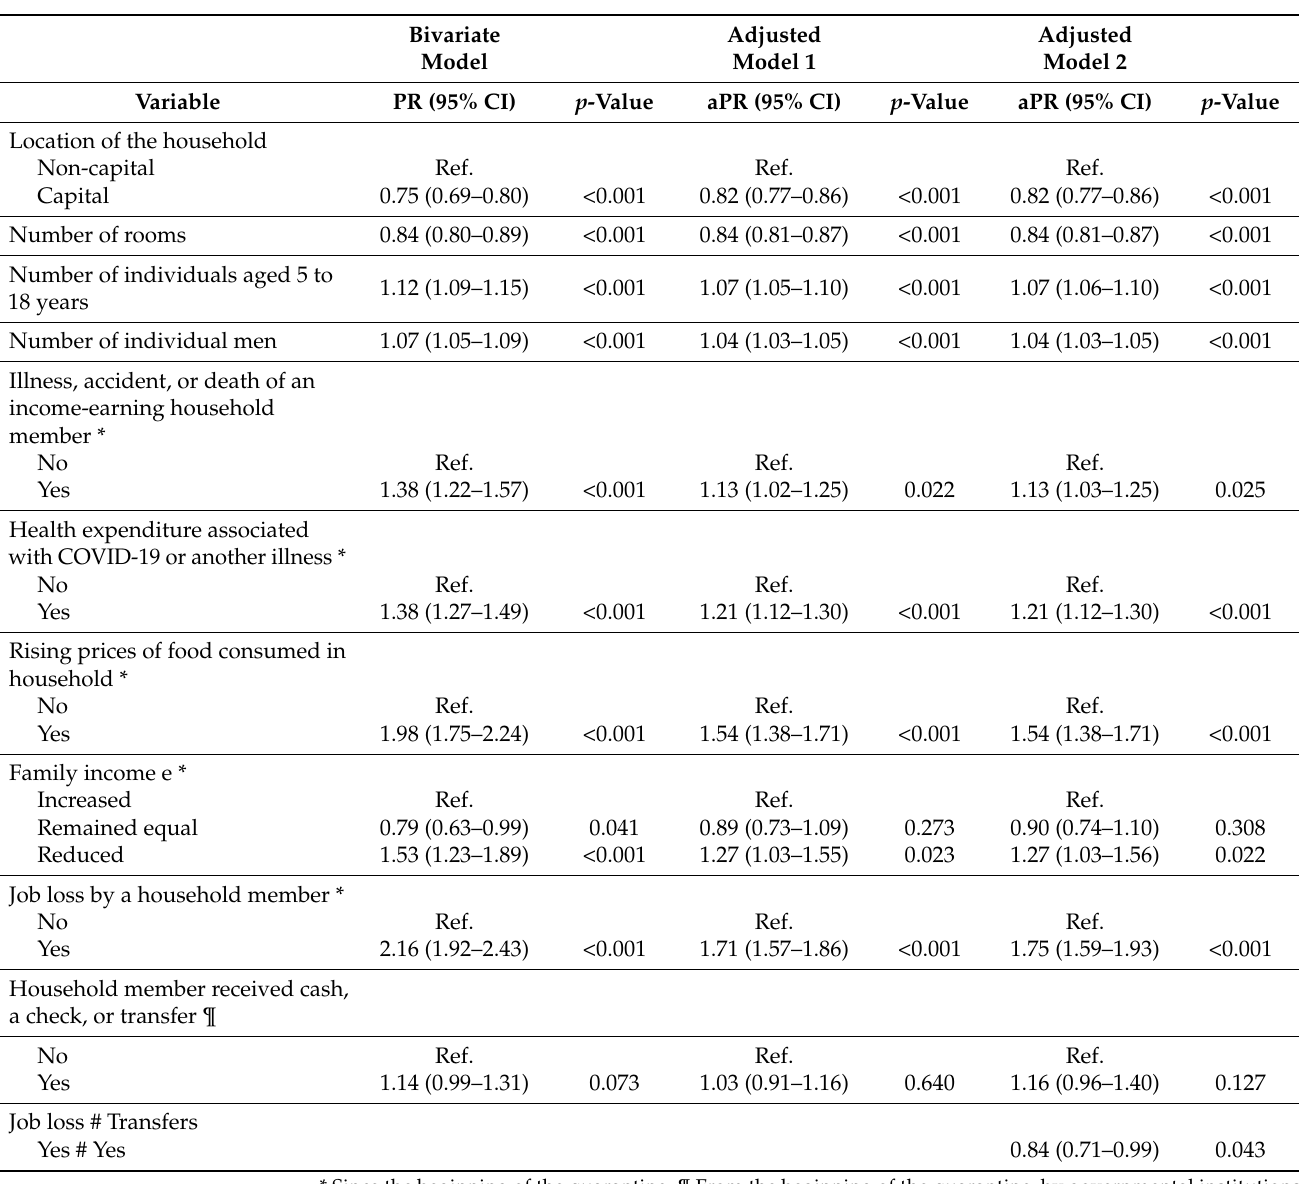
Table 3. Factors associated with food insecurity ( n =